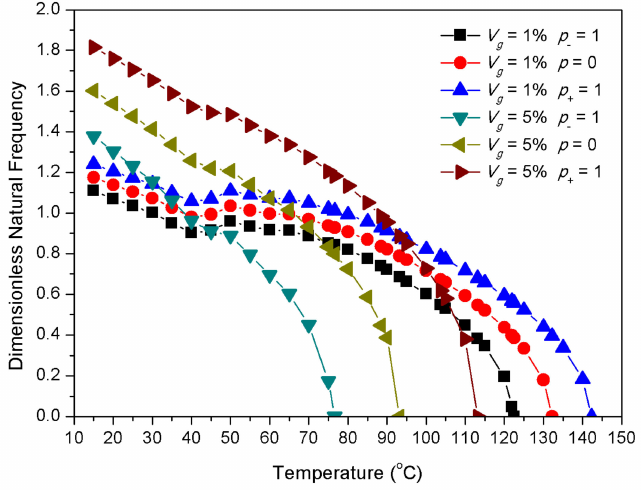
Figure 6. A comparison on dimensionless natural frequencies between the graphite volume fraction of 1% and 5% subjected to negative / non / positive